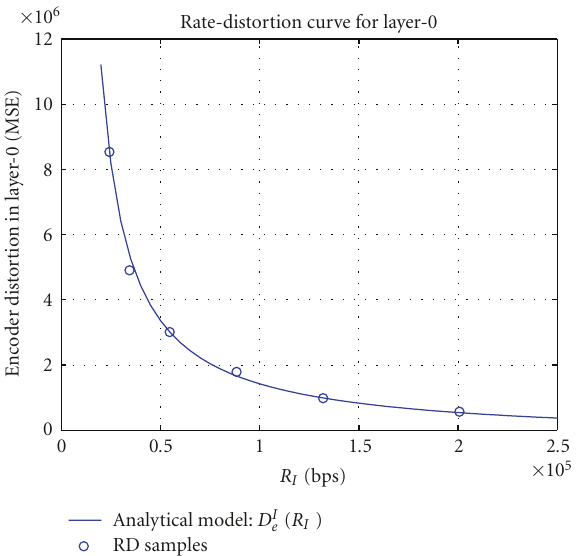
Figure 4: RD curve for layer 0 of the “Rena” video. Rate-distortion curve for layer-0